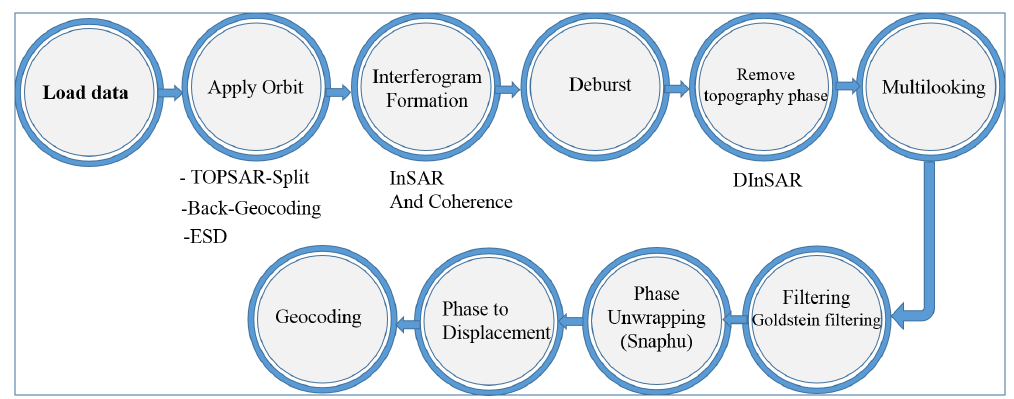
Figure 4. Workflow chart for the DInSAR processing using (SNAP)